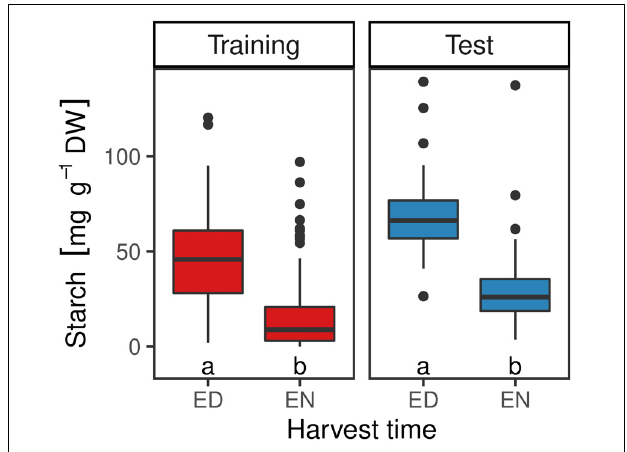
FIGURE 2 | Starch content in mg g − 1 DW in red clover plants of the training ( n = 449) and the test set ( n = 60) at the end of the day (ED) and at the end of the night (EN). Medians within the two sets with no letter in common are significantly different (Wilcoxon signed-rank test; α =